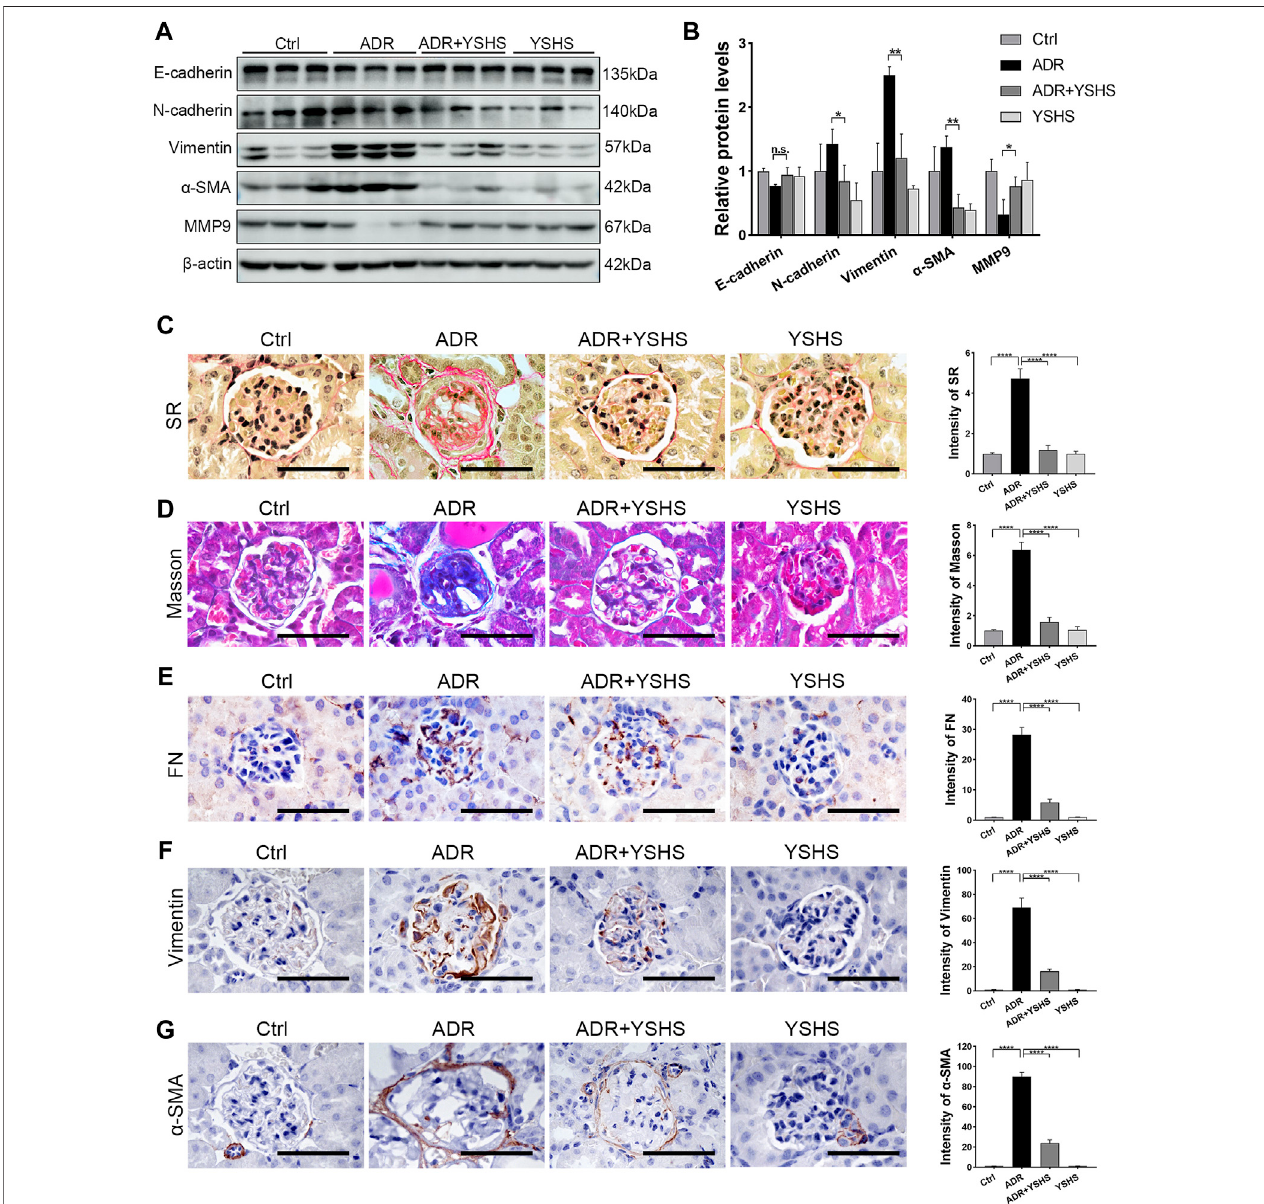
FIGURE3| YSHSgranulerelievesglomerular fi brosisintheFSGSmodel. (A) Western blotanalysisshowstheexpressionlevelsoftheindicatedproteinsextracted fromkidneytissuesineachgroup. (B) Thequanti fi cationoftherelativeintensitiesofblotsshowedthattheYSHSgranulereducedtheexpressionofN-cadherin,Vimentin, and α -SMA in ADR-induced FSGS models. N = 3 in each group, the data were shown as mean ± SD, one-way ANOVA analysis followed by Tukey post-hoc tests as appropriate for multiple comparisons, * p < 0.05, ** p < 0.01. (C – D) The results of Sirius Red (SR) staining (C) and Masson staining (D) showed that the YSHS granuleobviouslydecreasedtheaccumulationofcollagen fi bersinglomerulusofADR-inducedFSGSmodelmice. (E – G) TheresultsofIHCstainingFN (E) ,Vimentin (F), and α -SMA (G) showed that the YSHS granule obviously decreased the expression of FN, α -SMA, and Vimentin in the glomerulus of ADR-induced FSGS model mice. N = 6 in each group, the data were shown as mean ± SD, one-way ANOVA analysis followed by Tukey post-hoc tests as appropriate for multiple comparisons, **** p < 0.0001. scale bar: 50